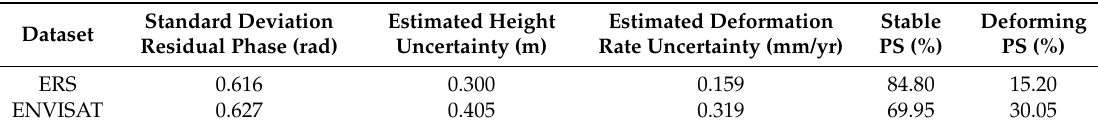
Figure 5. Results of the IPTA analysis performed on the ERS dataset (1999–2000) and ENVISAT dataset (2004–2009). Below the GNSS benchmark location at the site of Anchor Bay and Il-Qarraba. Table 3. Statistical parameters of the interferometric